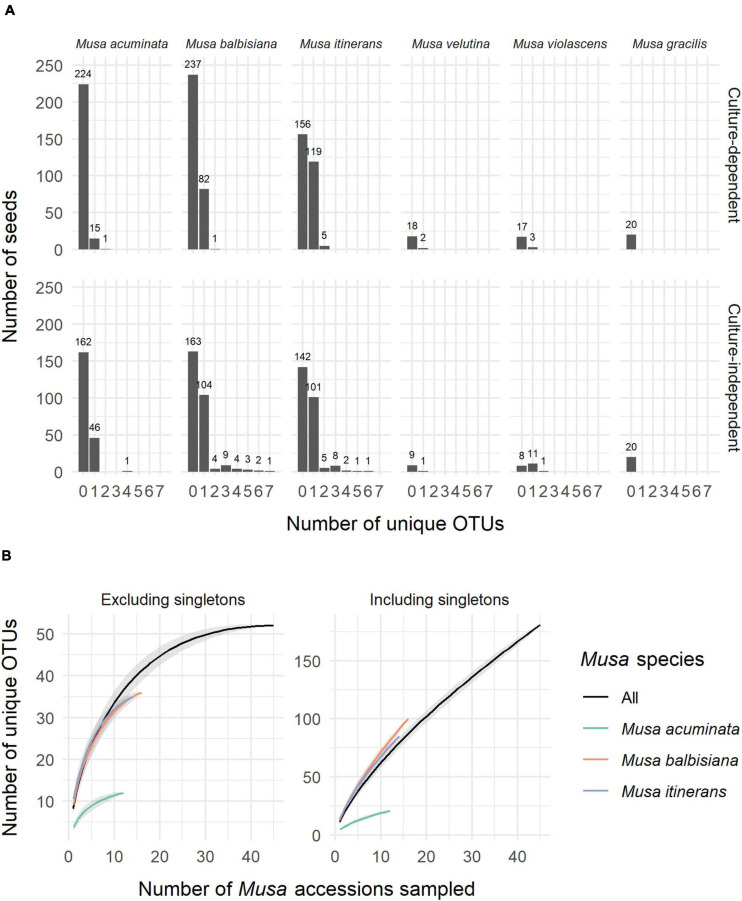
(A) The number of unique OTUs per seed for each species of Musa from both the culture-dependent and independent approaches. (B) Species accumulation curves of OTUs by number of Musa accessions sampled, both excluding and including singletons and showing distinction between the three most sampled Musa species. Standard error is shaded grey around the lines.